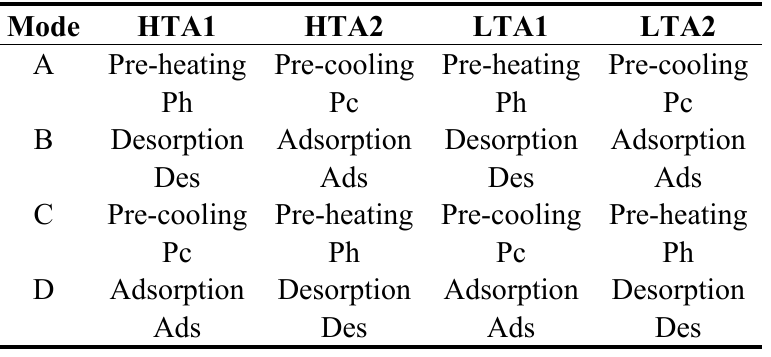
Table 1. Operation scheme of the cascading cycle without mass recovery.